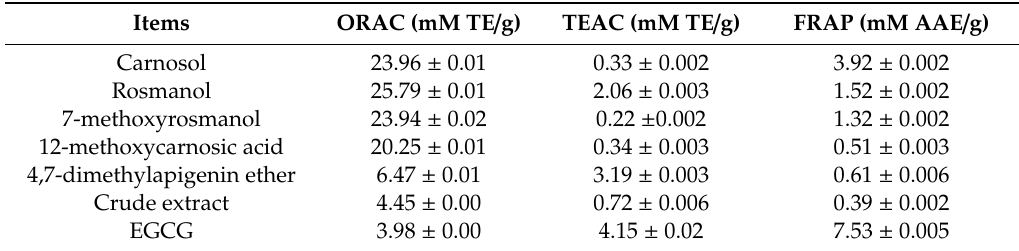
Table 5. Total antioxidant capacity of S. aurita